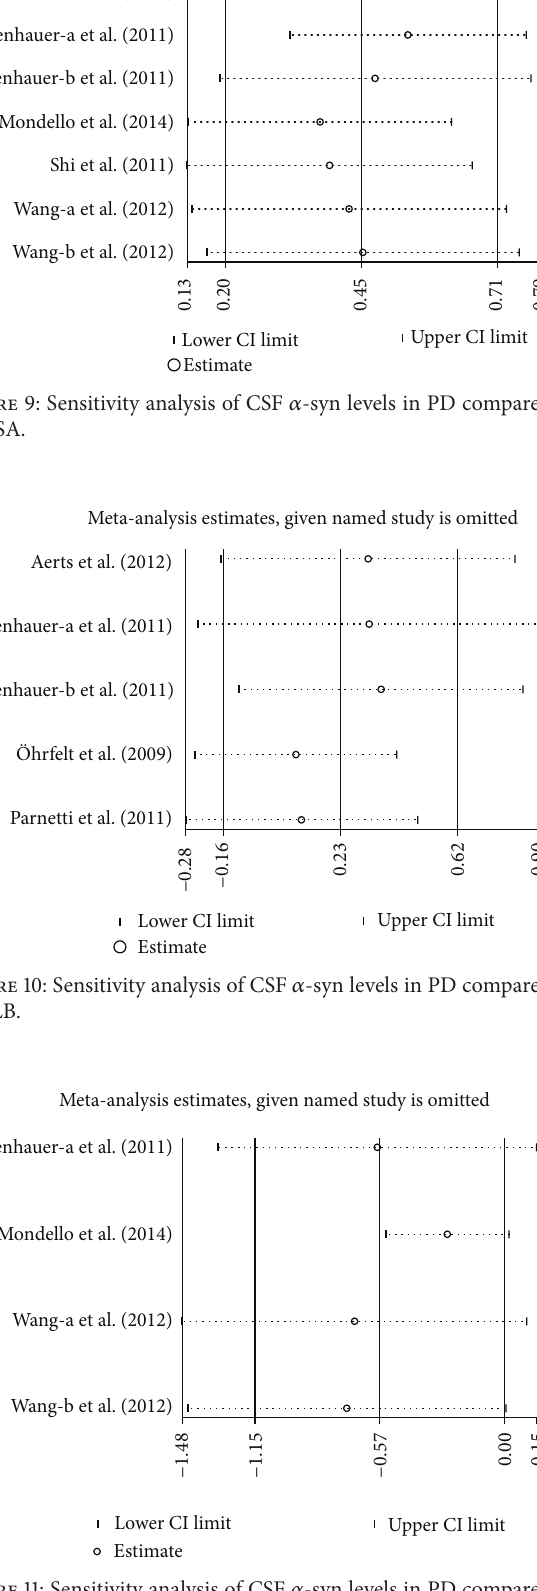
Figure 11: Sensitivity analysis of CSF 𝛼 -syn levels in PD compared to PSP.